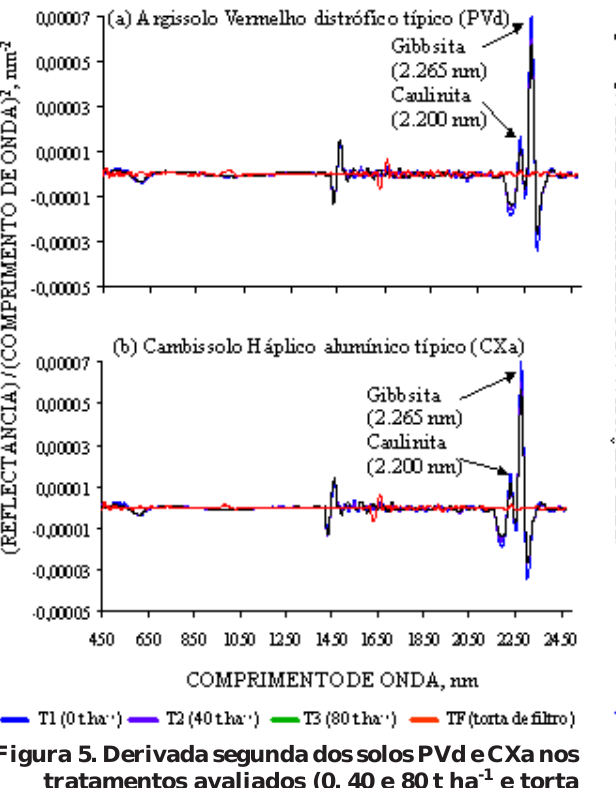
Figura 6. Derivada segunda dos solos LVd e LVdf nos tratamentos avaliados (0, 40 e 80 t ha -1 e torta de